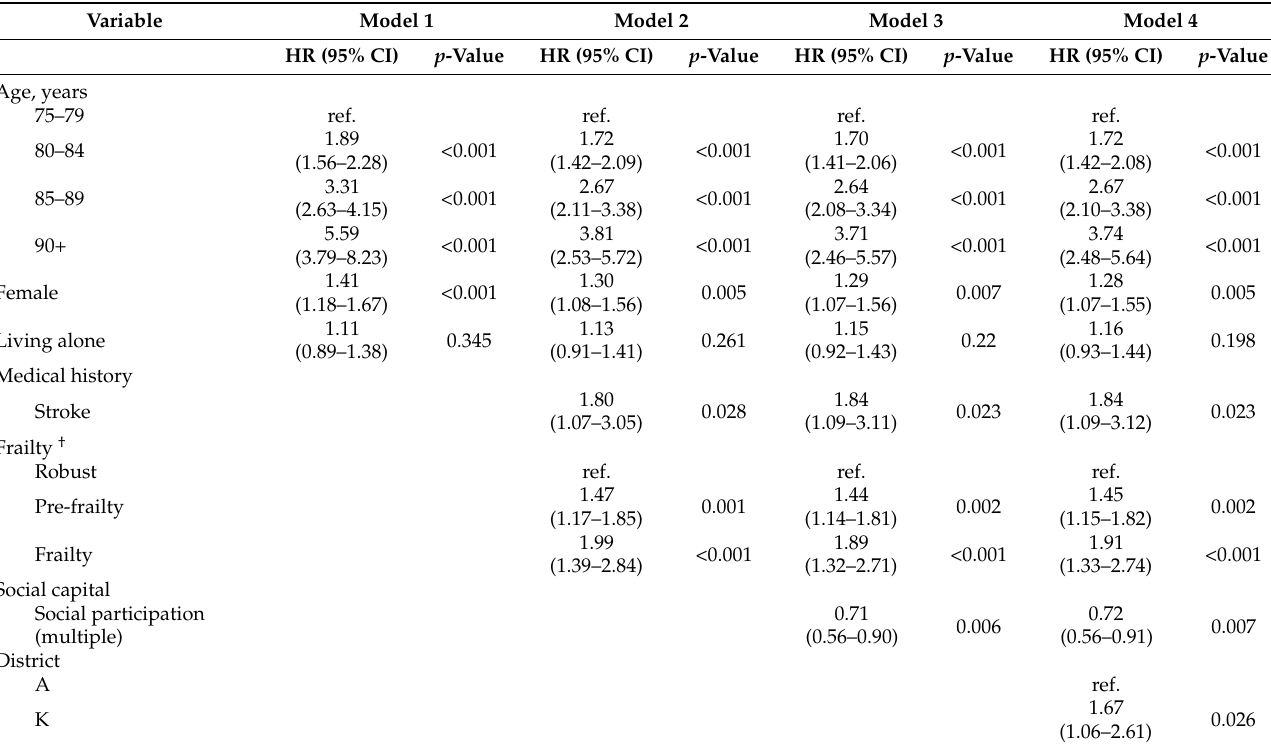
Table 3. Cox proportional hazards analysis for incident disability.